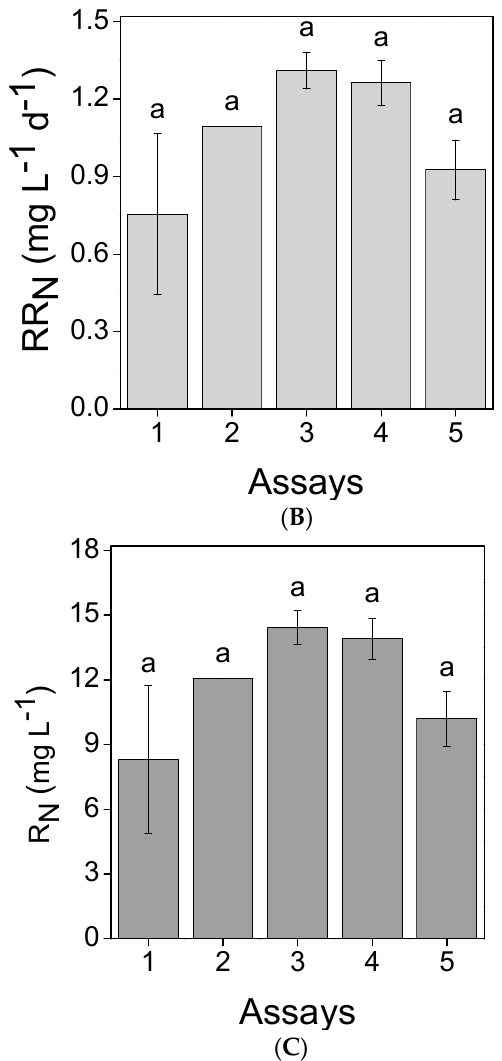
Figure 4. Nitrogen (nitrate + nitrite) removal parameters obtained by C. vulgaris cultures grown in raw and diluted secondary-treated paper industry effluent (assays 1–5): ( A ) removal efficiency (%R N ); ( B ) average removal rate (RR N ); and ( C ) mass removal (R N ). Error bars correspond to the standard deviation of the mean obtained from two independent experiments. Mean values sharing at least one common letter (shown above the bars) are not statistically different ( p >0.05).